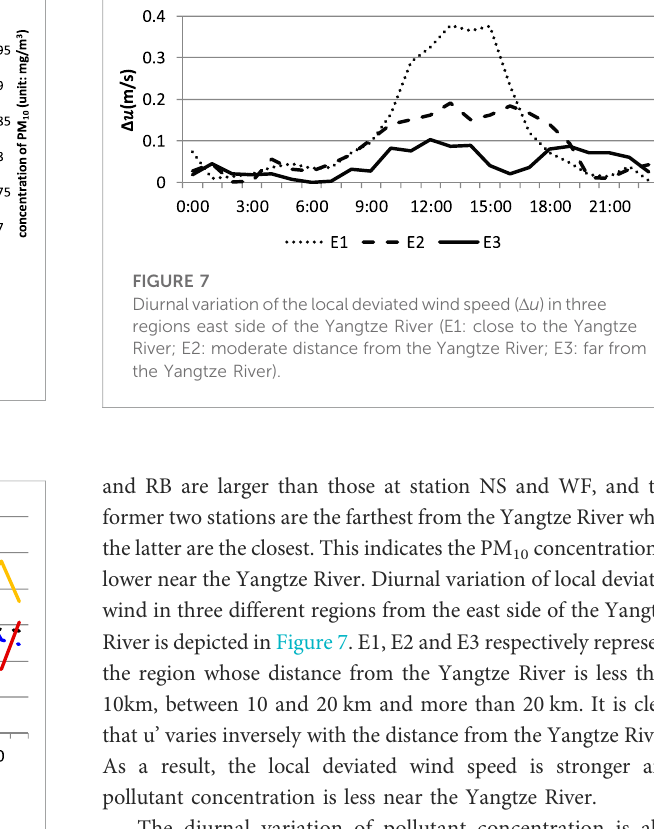
FIGURE 6 Diurnal variation of PM 10 anomalies at individual stations.